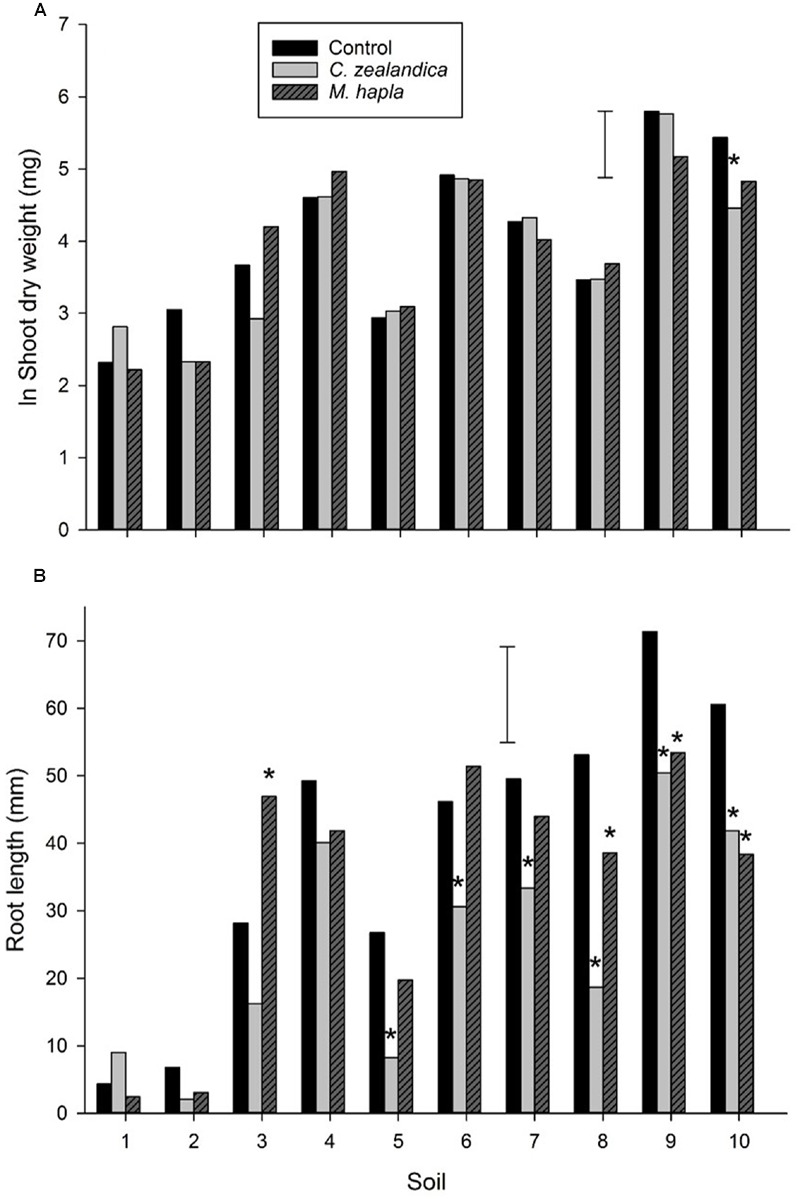
Experiment 1: Growth of white clover shoots (A) and roots (B), without invertebrate pests (control) or inoculated with Costelytra zealandica or Meloidogyne hapla. Error bars are lsd 5%. Soils are arranged from most northerly (1) to most southerly (10). Astrices denote significant difference to control within each soil.